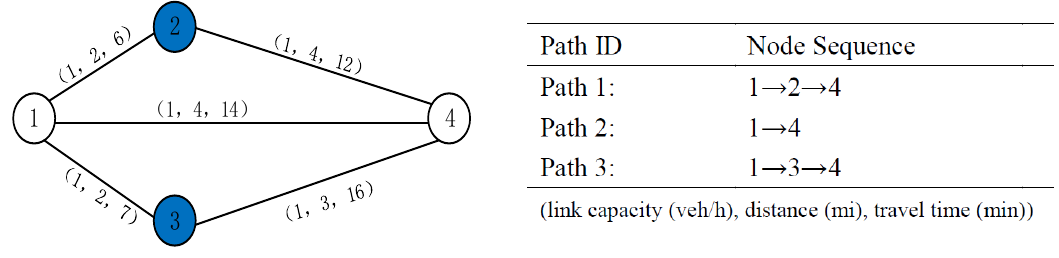
Figure 1. A numerical network presented in He et al. [8].